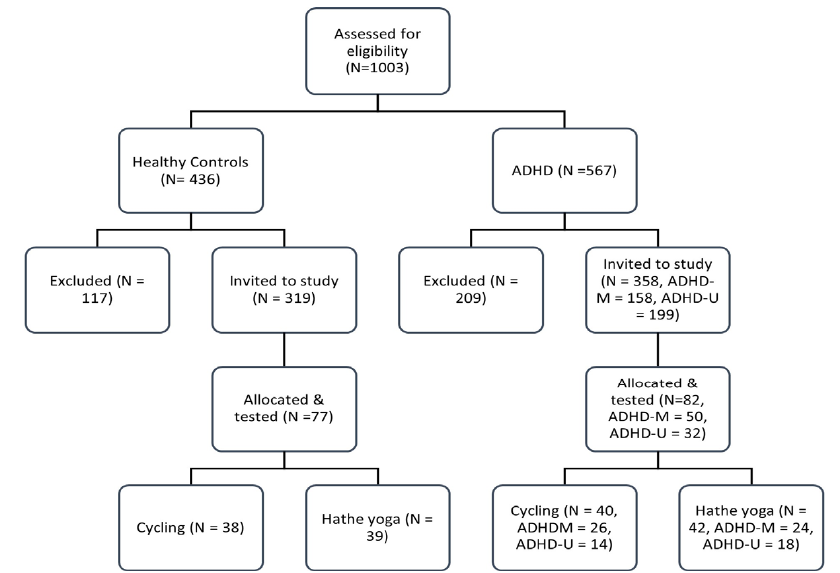
Figure 1. Flow diagram showing screening and allocation of the different groups. ADHD ‐ M indicates medicated with psychostimulants whilst ADHD ‐ U indicates medication free. Although the two groups were combined in the final analysis to increase statistical power, the initial randomisation was stratified according to three groups (HC, ADHD ‐ M and ADHD ‐ U). Demographic and clinical characteristics of the two groups are detailed in Table 1.